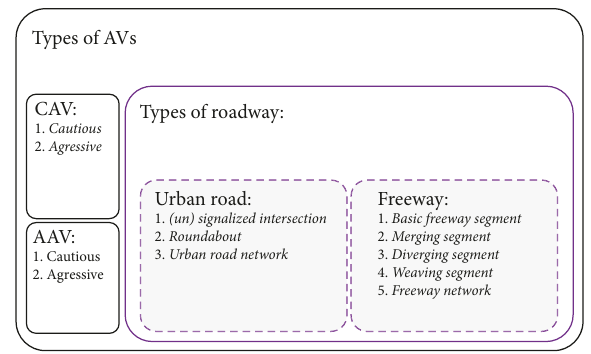
Figure 1: Studied